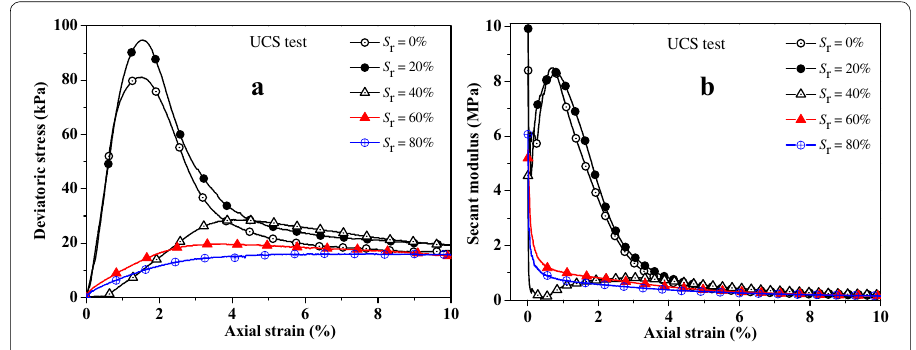
Fig. 12 Influence of S r on the response of silty-sand subjected to UCS tests a stress–strain response, b strain-dependent secant modulus